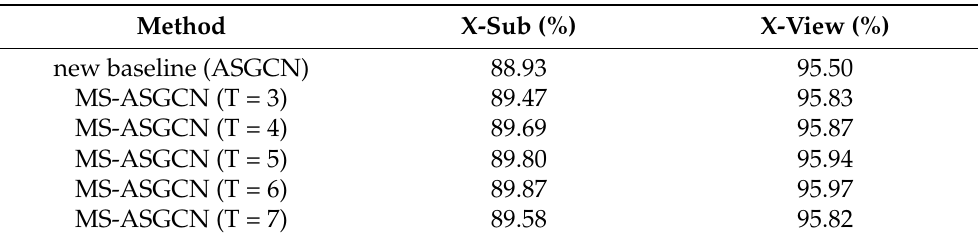
Table 4. Action recognition accuracy on the NTU-RGB+D dataset of MS-ASGCN with various numbers of stages.